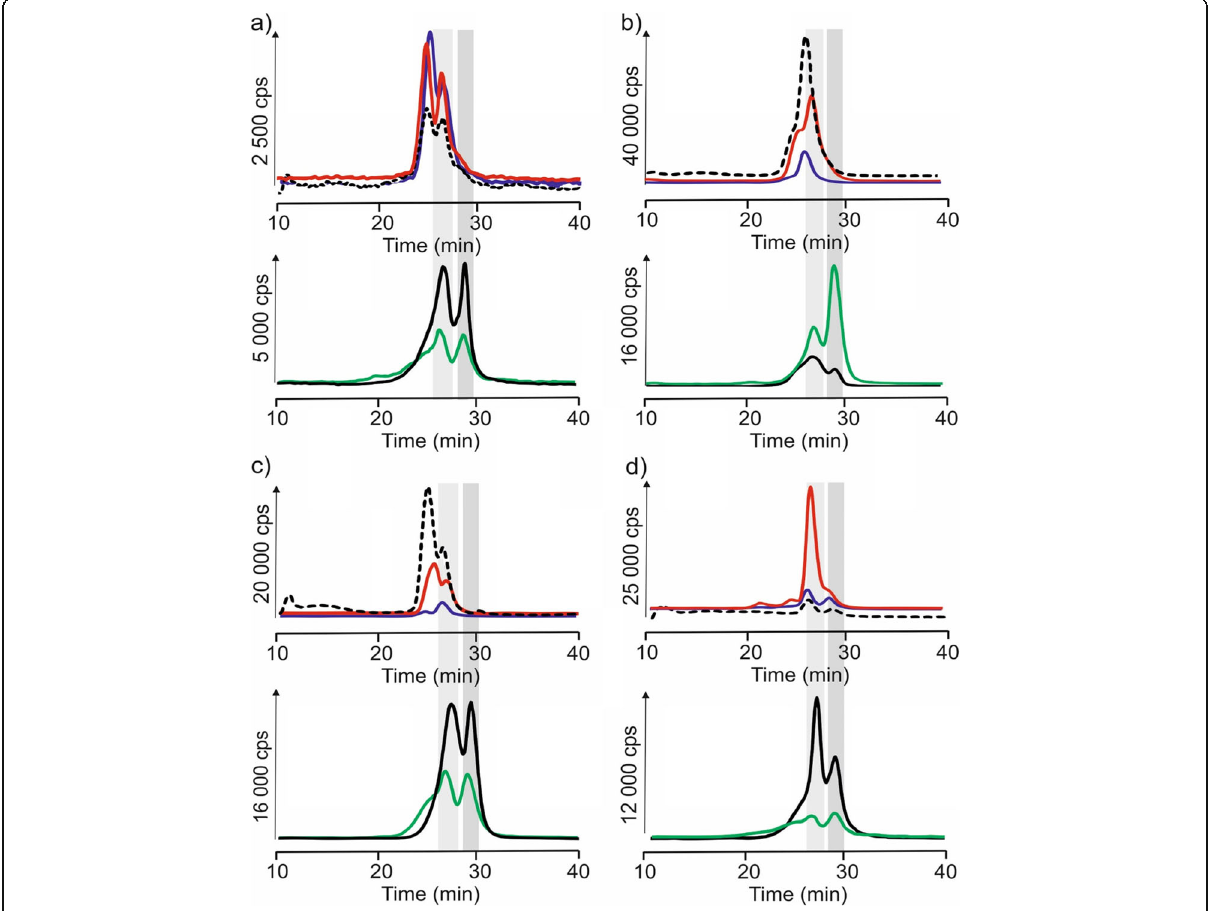
Fig. 1 SEC-ICP-MS chromatograms obtained for cobalt after analysis of extracts: ammonium acetate (red line), SDS (black dots), Tris-HCl (blue line), gastric (black line), and gastrointestinal (green line) a açai berries, b goji berries, c bilberries, d chia